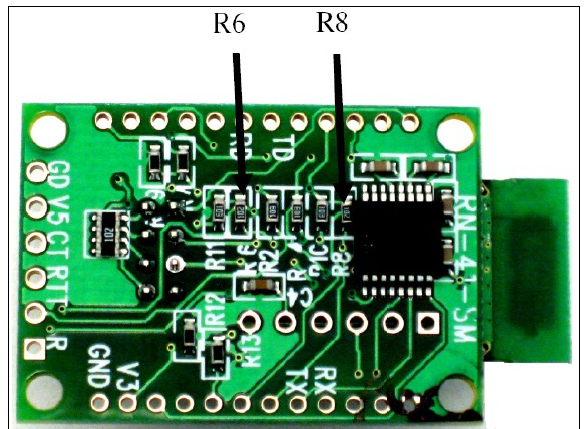
Figure 3. Resistances eliminated